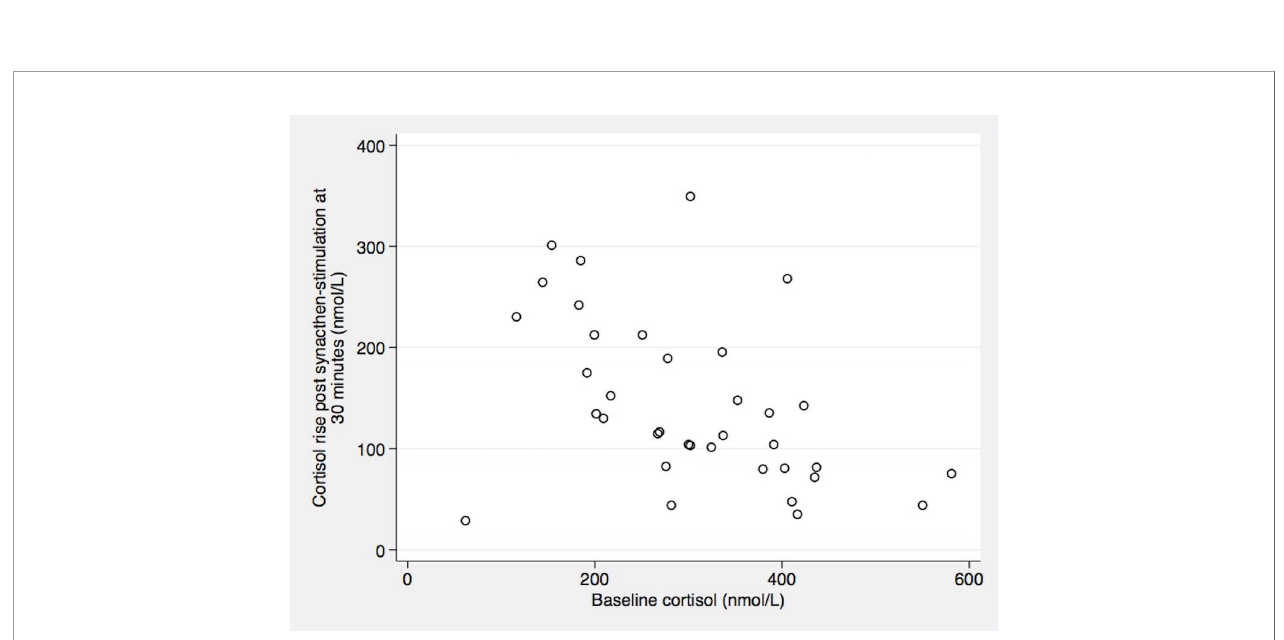
FIGURE 2 | Relation between baseline cortisol and cortisol rise post synacthen-stimulation at 30 minutes. Correlation Coef fi cient Spearman ’ s rho= -0.52 ( P